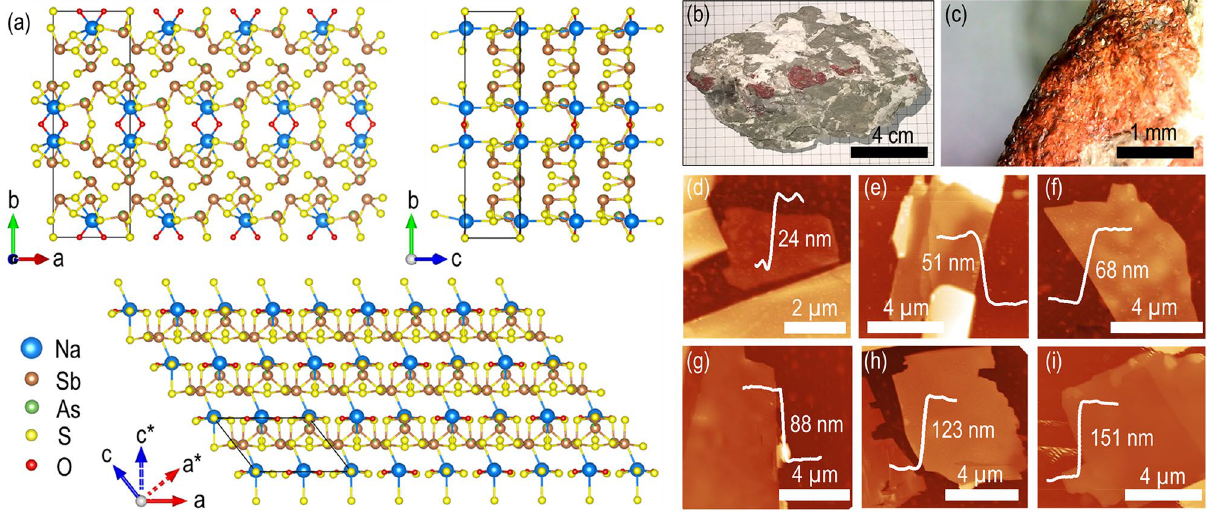
Figure 1. Gerstleyite crystal structure and flake exfoliation. ( a ) Projection of the gerstleyite crystal structure viewed along the c -axis, a -axis, and b -axis. ( b ) Picture of a natural bulk gerstleyite mineral rock. ( c ) Magnified view of one gerstleyite crystal area. ( d – i ) Captured AFM images of several mechanically exfoliated gerstleyite flakes, where the AFM line profiles signify the flake thickness and surface